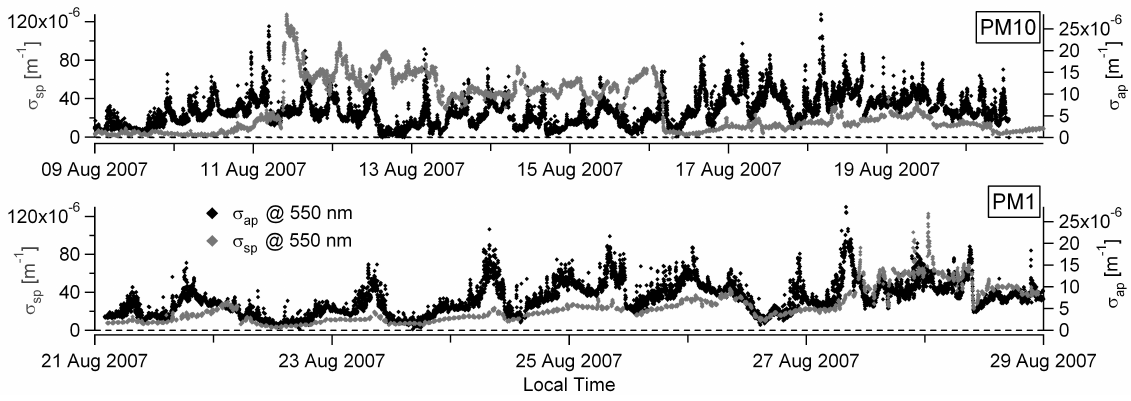
Fig. A5. PM 10 and PM 1 scattering ( σ sp ) and absorption coefficients ( σ ap ) measured by DOE/ARM with a nephelometer and a PSAP (particle Fig. A5. PM10 and PM1 scattering ( σ ) and absorption coefficients ( σ ) measured by DOE/ARM sp ap soot absorption photometer) at 550nm wavelength. Time resolution is with a nephelometer and a PSAP (particle soot absorption photometer) at 550 nm wavelength. Time resolution is 1 min.